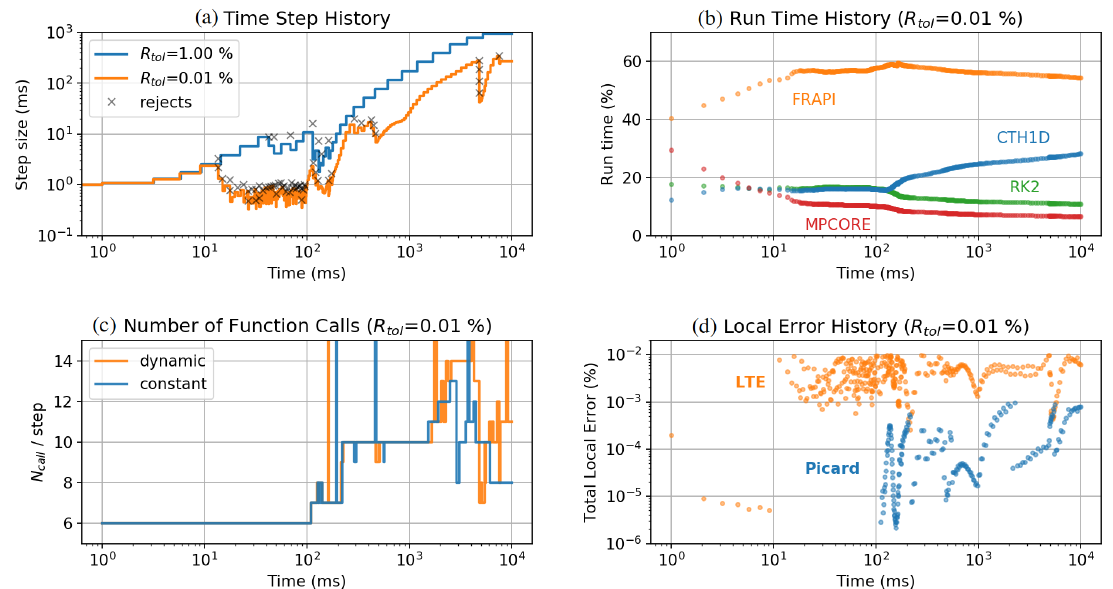
Figure 7. Fuel assembly simulation performance: ( a ) code run-time and ( b ) total power peak value error as the functions of relative tolerance R tol .